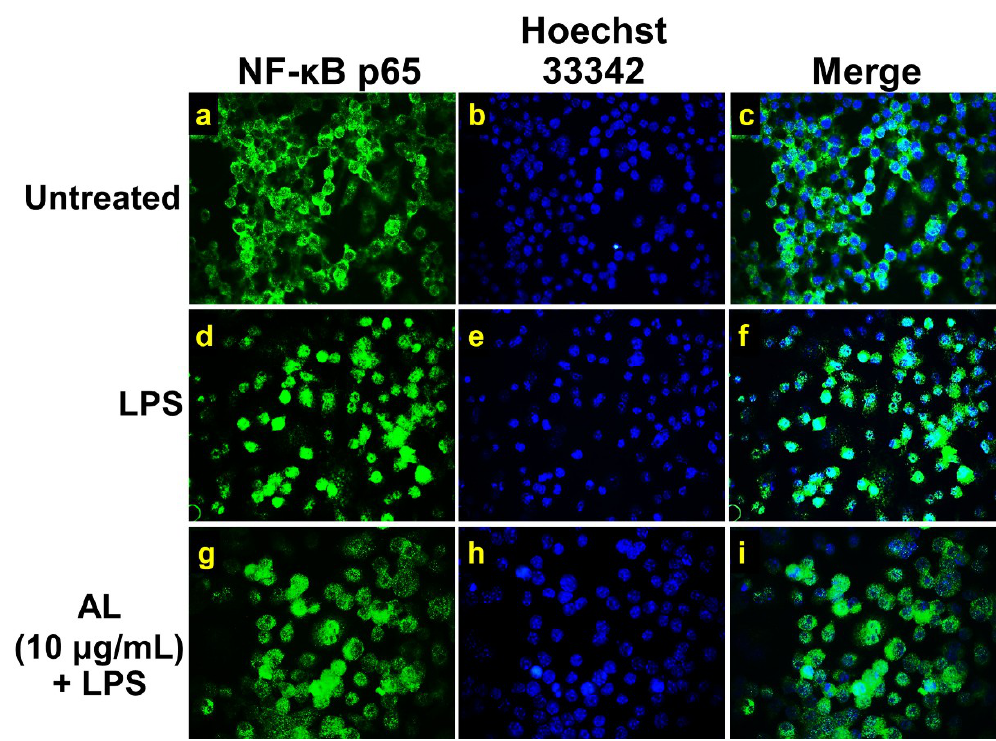
Figure 4. The inhibitory e ff ects of AL extract on nuclear localization of nuclear factor-kappa B (NF- κ B) in RAW 267.4 cells. Representative images from immunofluorescence study showing NF- κ B staining (green) in untreated cells ( a – c ), LPS-stimulated cells ( d – f ), and AL-treated cells stimulated with LPS ( g – i ). Nuclei (blue) were stained with Hoechst 33342. The micrographs were captured at 100 × magnification, and data are representatives of three replicates.